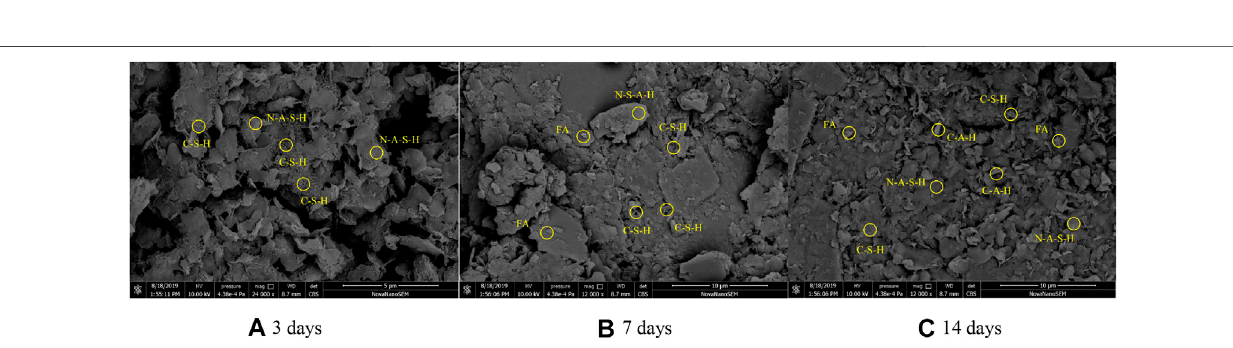
Frontiers in Materials |